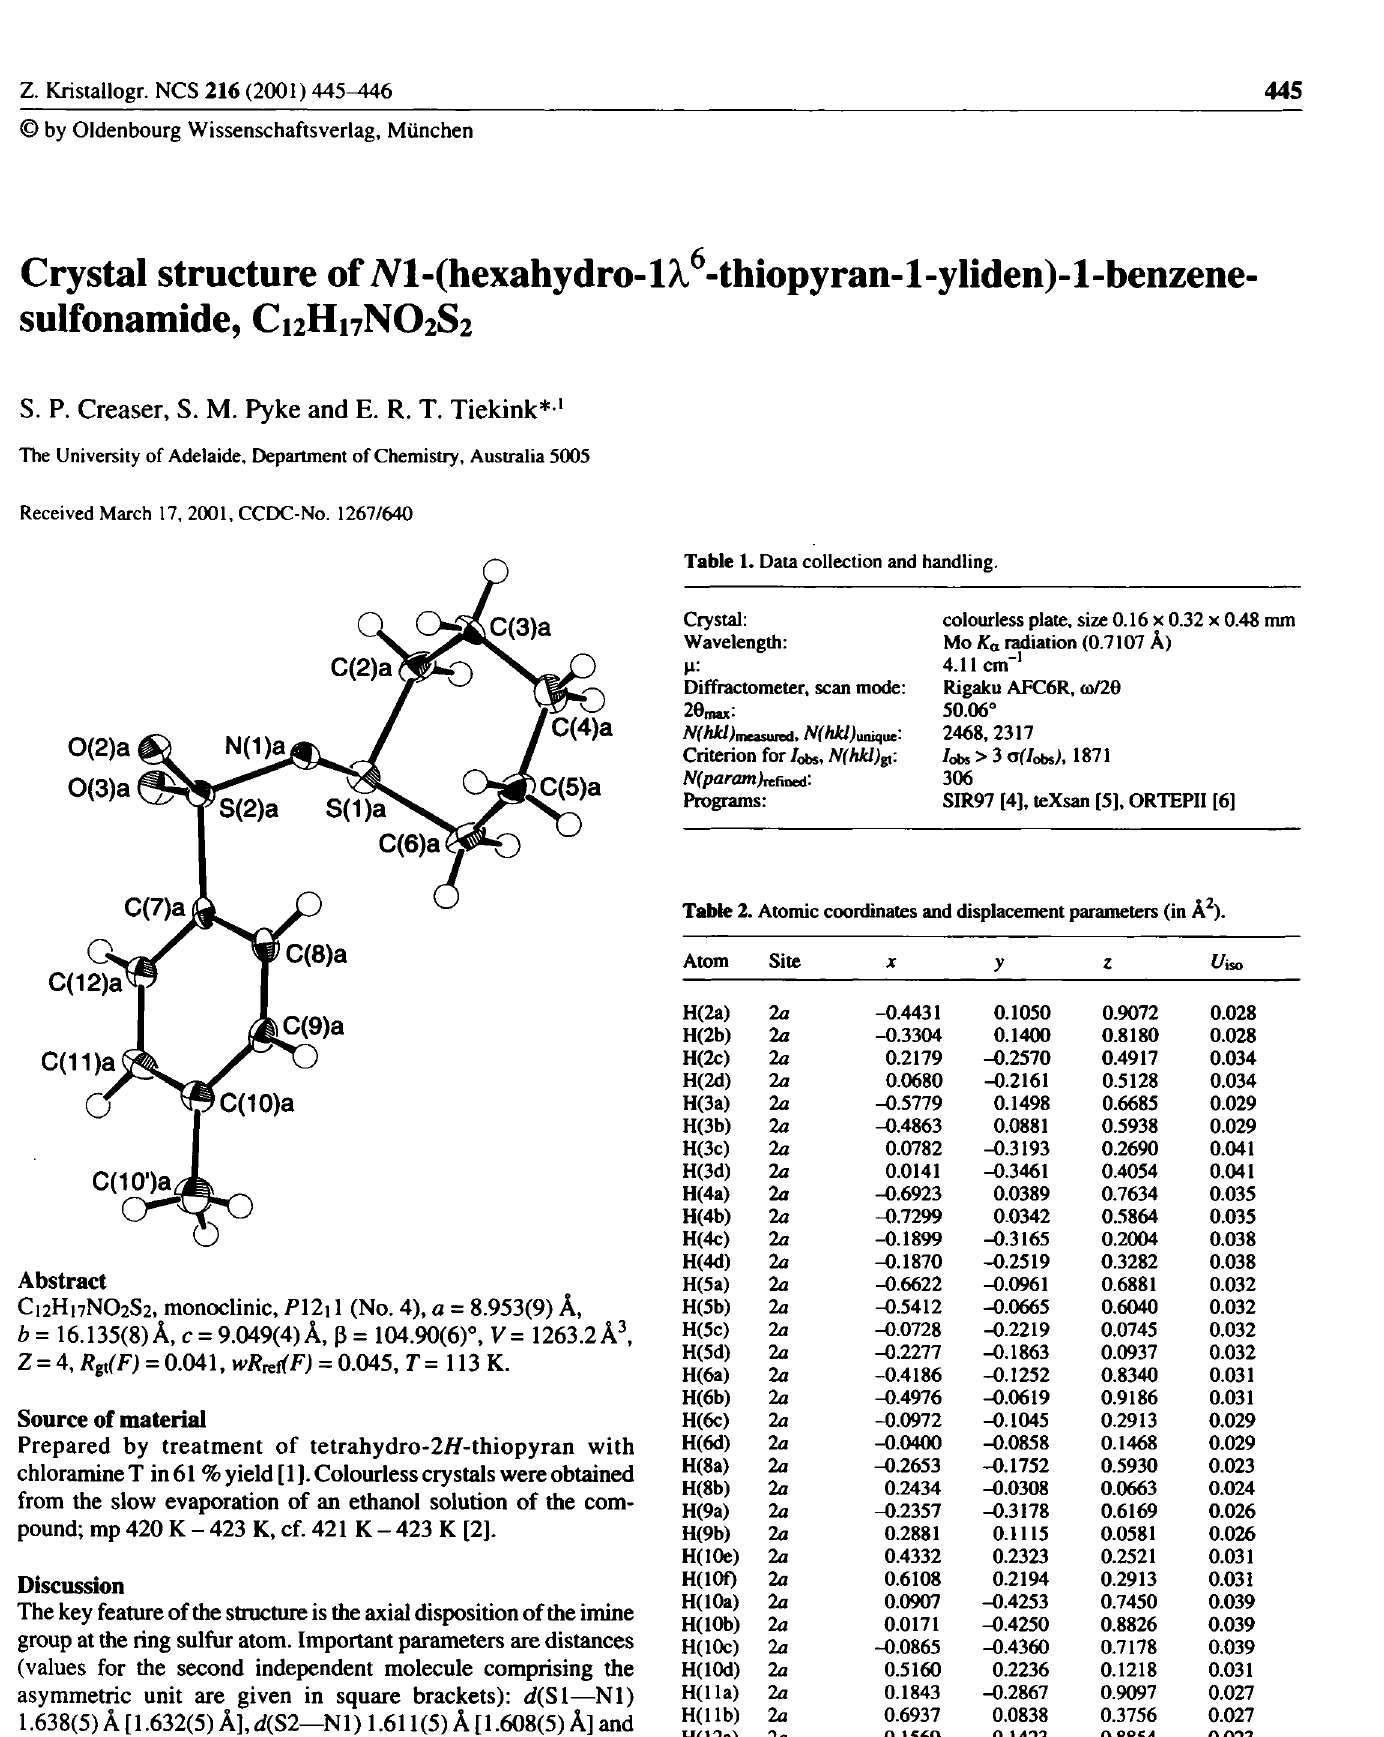
Table 2. Atomic coordinates and displacement parameters (in A 2